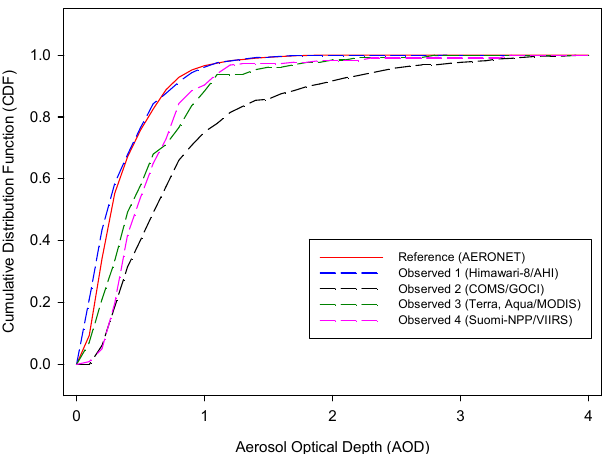
Figure 3. Cumulative distribution functions (CDFs) of AOD derived from AERONET (reference data), corresponding to AODs derived remotely from satellite imagery for Anmyondo during 2016 (training data).